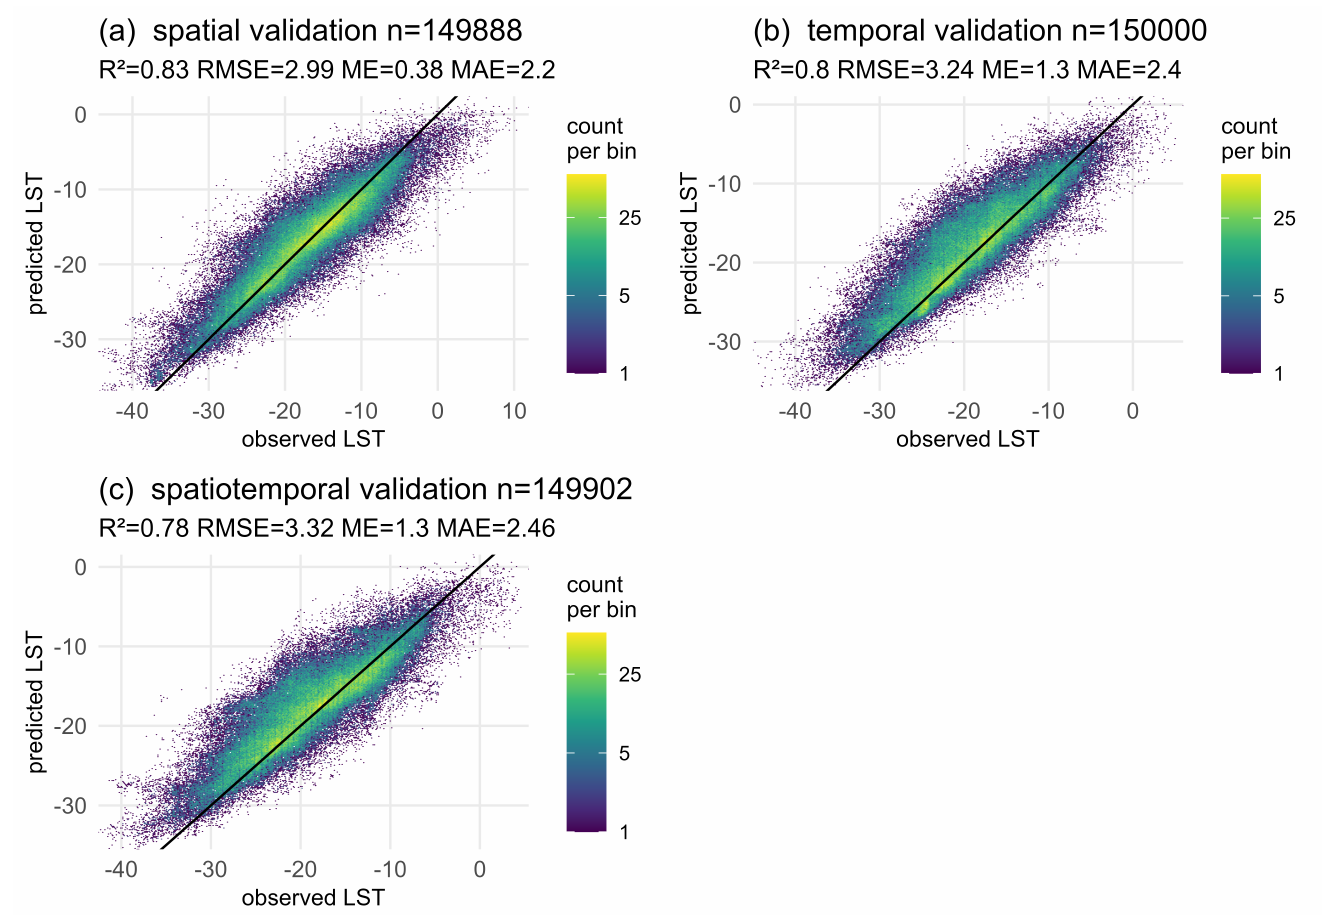
Figure 5. External model evaluation for the selected final model using ( a ) spatially unknown data, ( b ) temporally unknown data and ( c ) spatio-temporally unknown data. The scale shows the count of data points per bin (size = 300). Sample sizes are less than 150,000 for validations ( a , c ) because rare soil types 3 and 19 were not present in the training